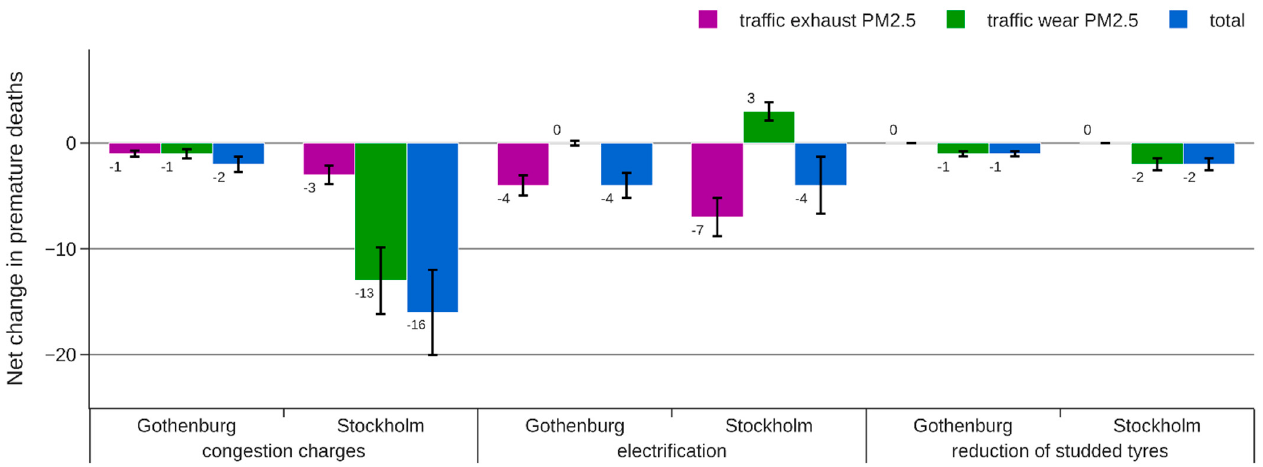
Figure 6. Estimated change in number of premature deaths for each of the abatement strategies following approach A (“WHO standard”). The error bars represent a 95% CI.